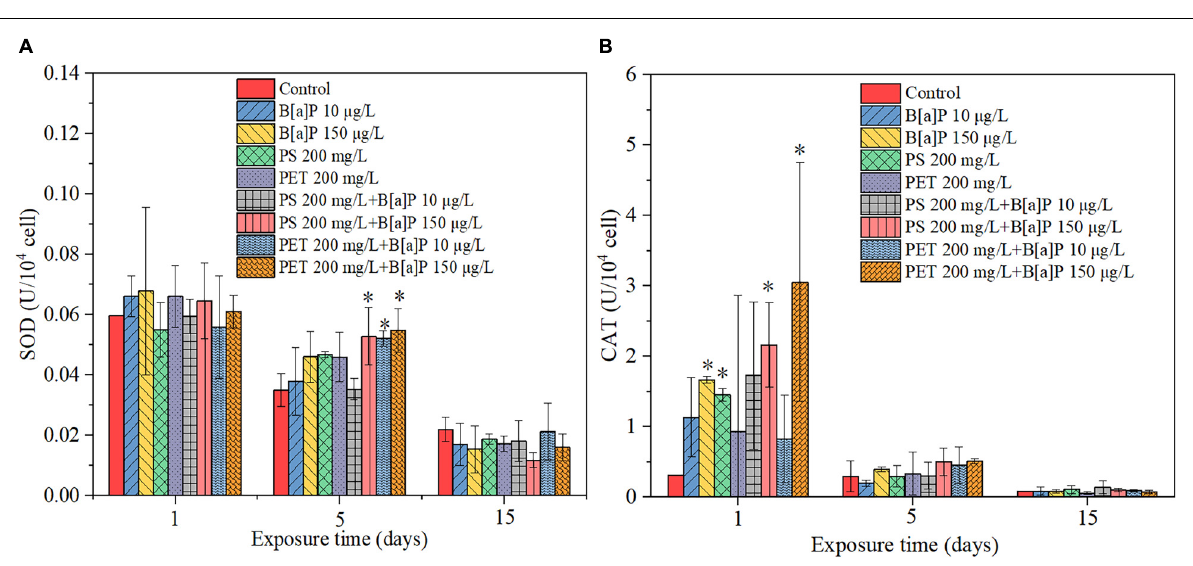
FIGURE 6 | (A) SOD and (B) CAT activity of C. muelleri to single microplastics, B[a]P, and their combinations. * indicates that significant differences compared to the control ( P <